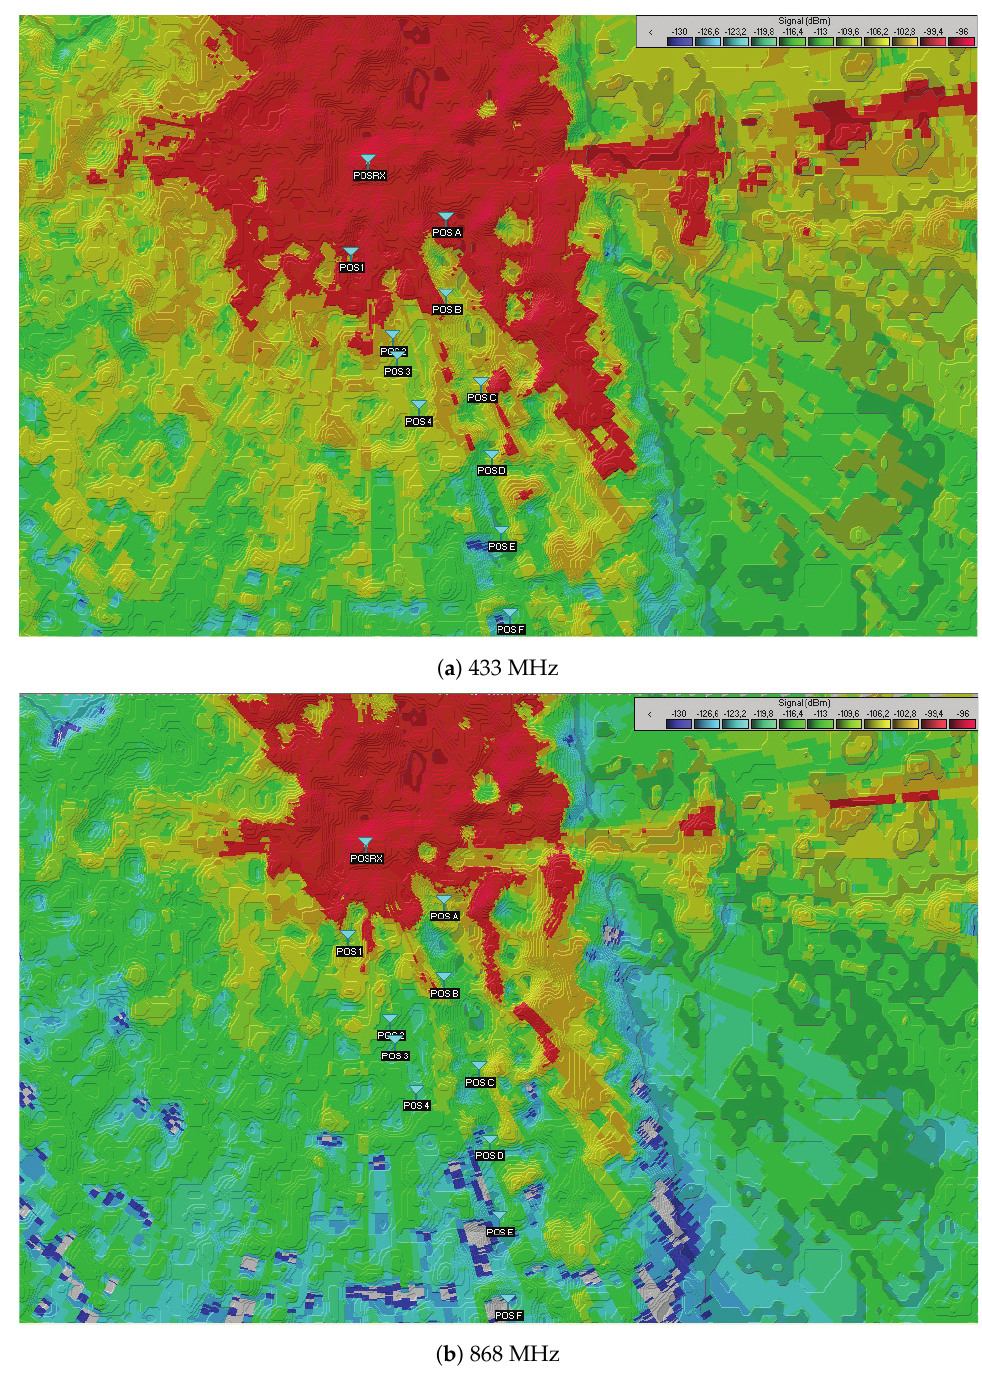
Figure 17. Theoretical coverage heat map for the forest environment area ( a ) 433 MHz band ( b ) 868 MHz